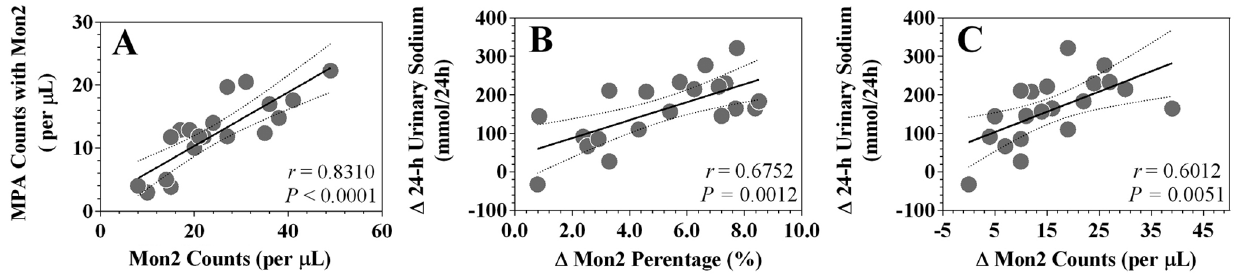
Figure 4. CD14 ++ CD16 + monocyte linear correlation analysis. A, shows the correlation between CD14 ++ CD16 + counts and CD14 ++ CD16 + MPA counts on day 4. B and C, show the correlation of net changes (day 4 minus day 3) between CD14 ++ CD16 + percentages/counts and 24 h urinary